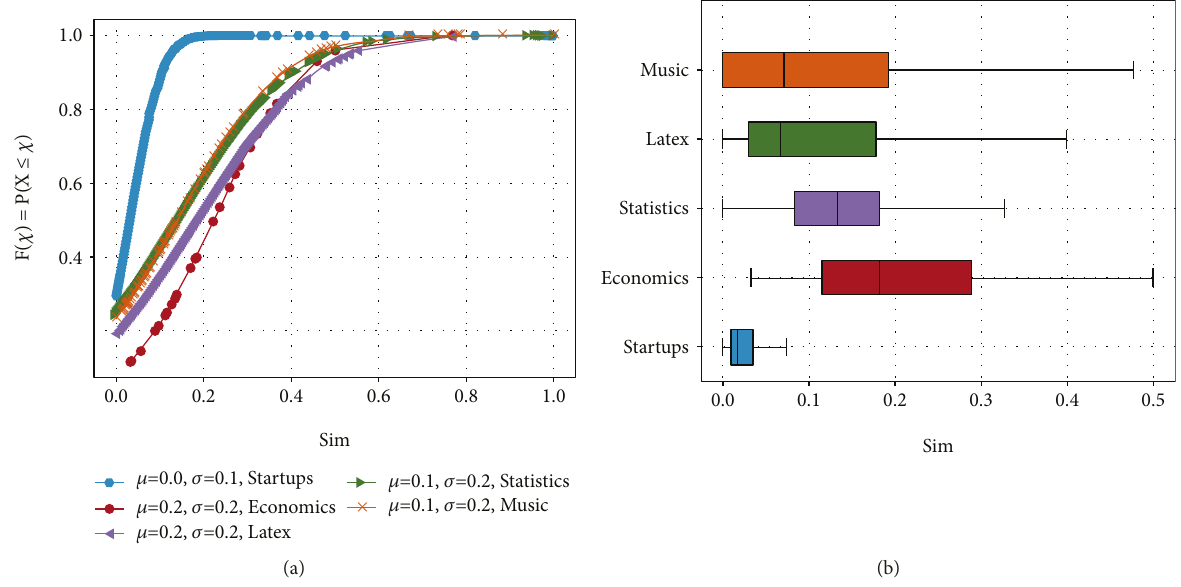
Figure 10: The fi gure shows the similarity of each pair of cascades as CDF (a) and as box plots (b). The similarity is de fi ned as described in